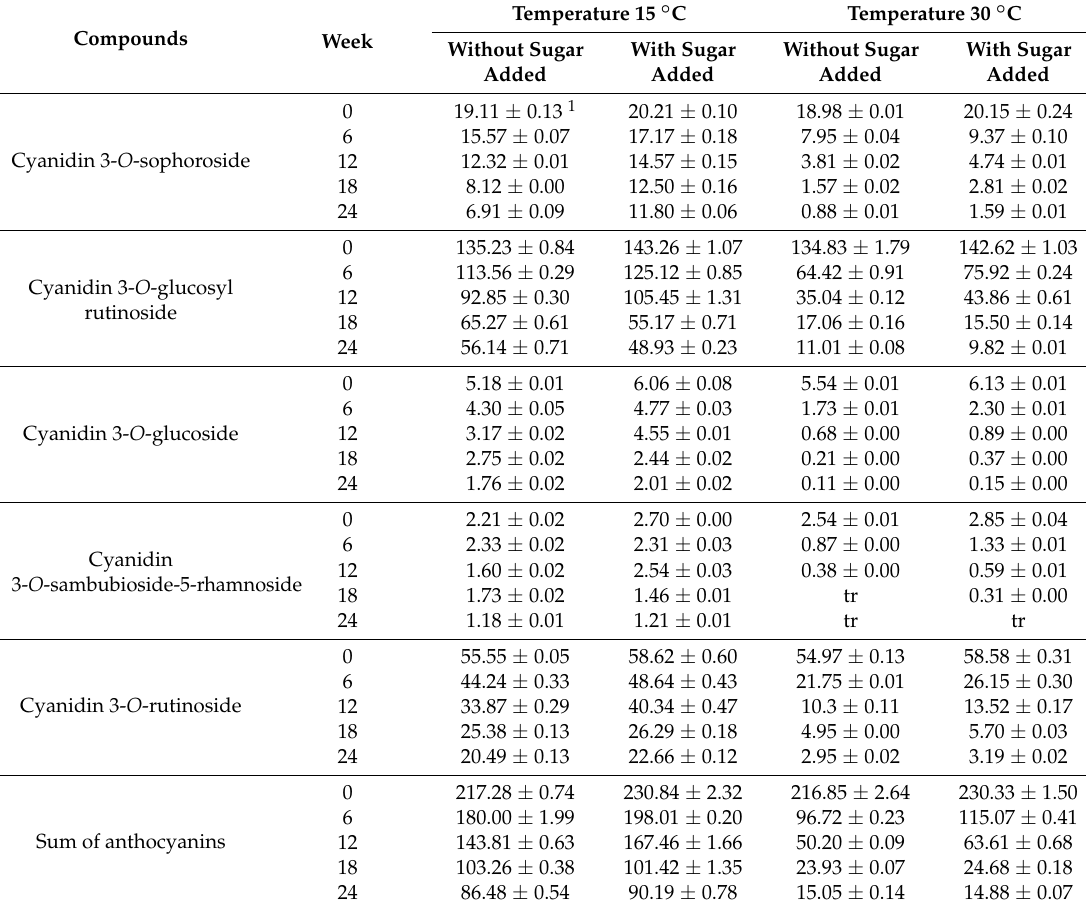
Table 4. Changes in anthocyanins content ( µ g/mL) during cherry liqueurs storage.